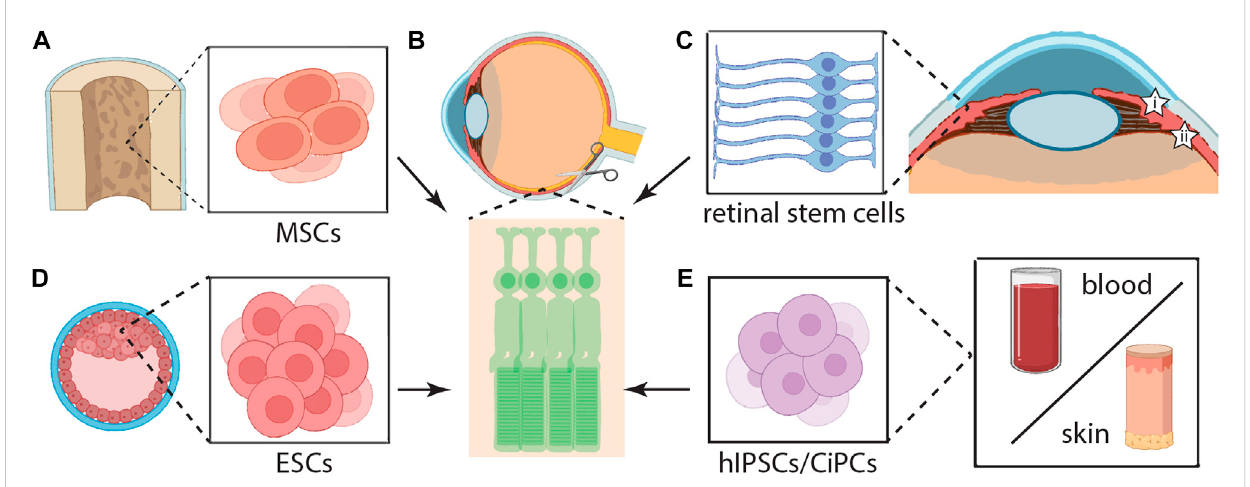
FIGURE 3 Stem Cell Transplantation and Regeneration . Many stem cells sources are being explored, and research efforts are focusing on streamlining regeneration methods to convert these stem cells (B) into healthy photoreceptors that can survive subretinal transplantation ( scissors ) while retaining light-responsive properties. Here, we highlight the origin and conversion of the following cells into photoreceptors, mesenchymal stem cells (MSCs) (A) , retinalstemcells (C) fromtheciliarymargin( shownbyi&ii ),embryonicstemcells(ESCs) (D) ,humaninducedpluripotentstemcells(hiPSCs) (E) ,and chemically-induced photoreceptor-like cells (CiPCs) (E) derived from fi